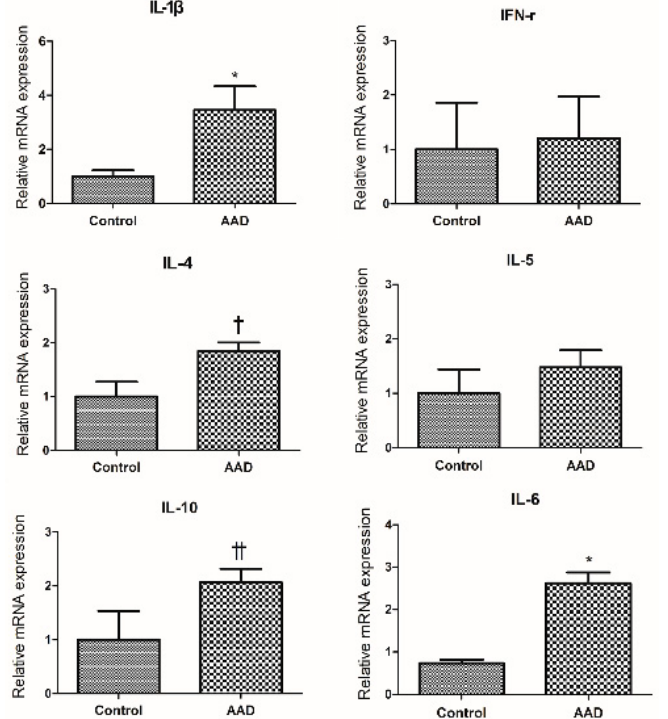
Figure 1. Comparison of cytokine expression between the allergic airway disease (AAD) and control groups by qRT-PCR. Interleukin (IL)-1 β and IL-6 levels were significantly higher in the intestinal mucosa of AAD mice than in the control group (* p < 0.05). IL-4 and IL-10 levels showed an increasing trend in AAD mice († p = 0.058 and †† p = 0.067, respectively). Table 1. Colonic changes, including the measured colon length, colon weight, stool score, were analyzed as described in Materials and Methods. Data are presented as a mean ± standard deviation (n = 10 per group, * p < 0.05 vs control,